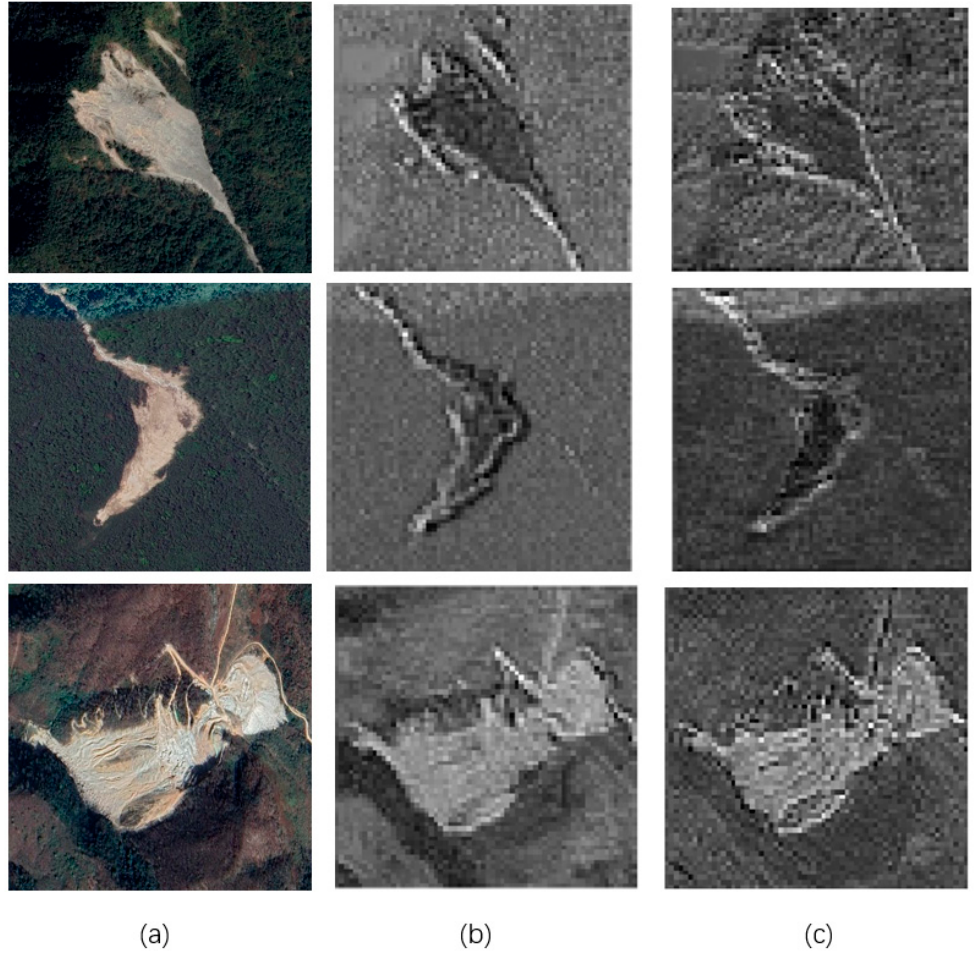
Figure 10. Comparison of the (64 × 64) size features extracted by the Mini network with and without the attention mechanism (CBAM). ( a ) The original images, ( b ) the features extracted with CBAM, and ( c ) the features extracted without CBAM.